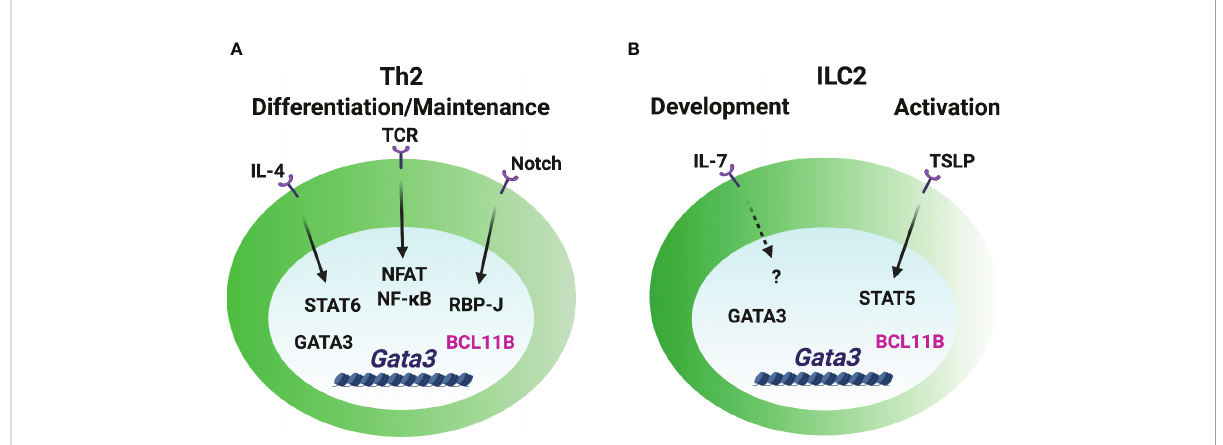
FIGURE 3 GATA3 induction in Th2 cells and ILC2s. (A) The Gata3 promoters are critical for the GATA3 induction during Th2 cell differentiation. IL-4/STAT6 directly and vigorously induces GATA3 expression. Notch signal regulates Gata3 promoter activity in CD4 T cells. TCR/NFAT/NF- k B signal is involved in GATA3 induction. GATA3 may self-regulate its expression in Th2 cells under certain circumstances. BCL11B works as a repressive regulator of GATA3 expression in already differentiated Th2 cells. (B) The booster of GATA3 induction during ILC2 lineage determination is unclear. IL-7 signaling may play a role in GATA3 expression in ILC2s. The release of repressive factor BCL11B may be important for the high levels of GATA3 expression. TSLP/STAT5 regulates GATA3 expression in the mature ILC2s, but it is dispensable for GATA3 hi ILC2